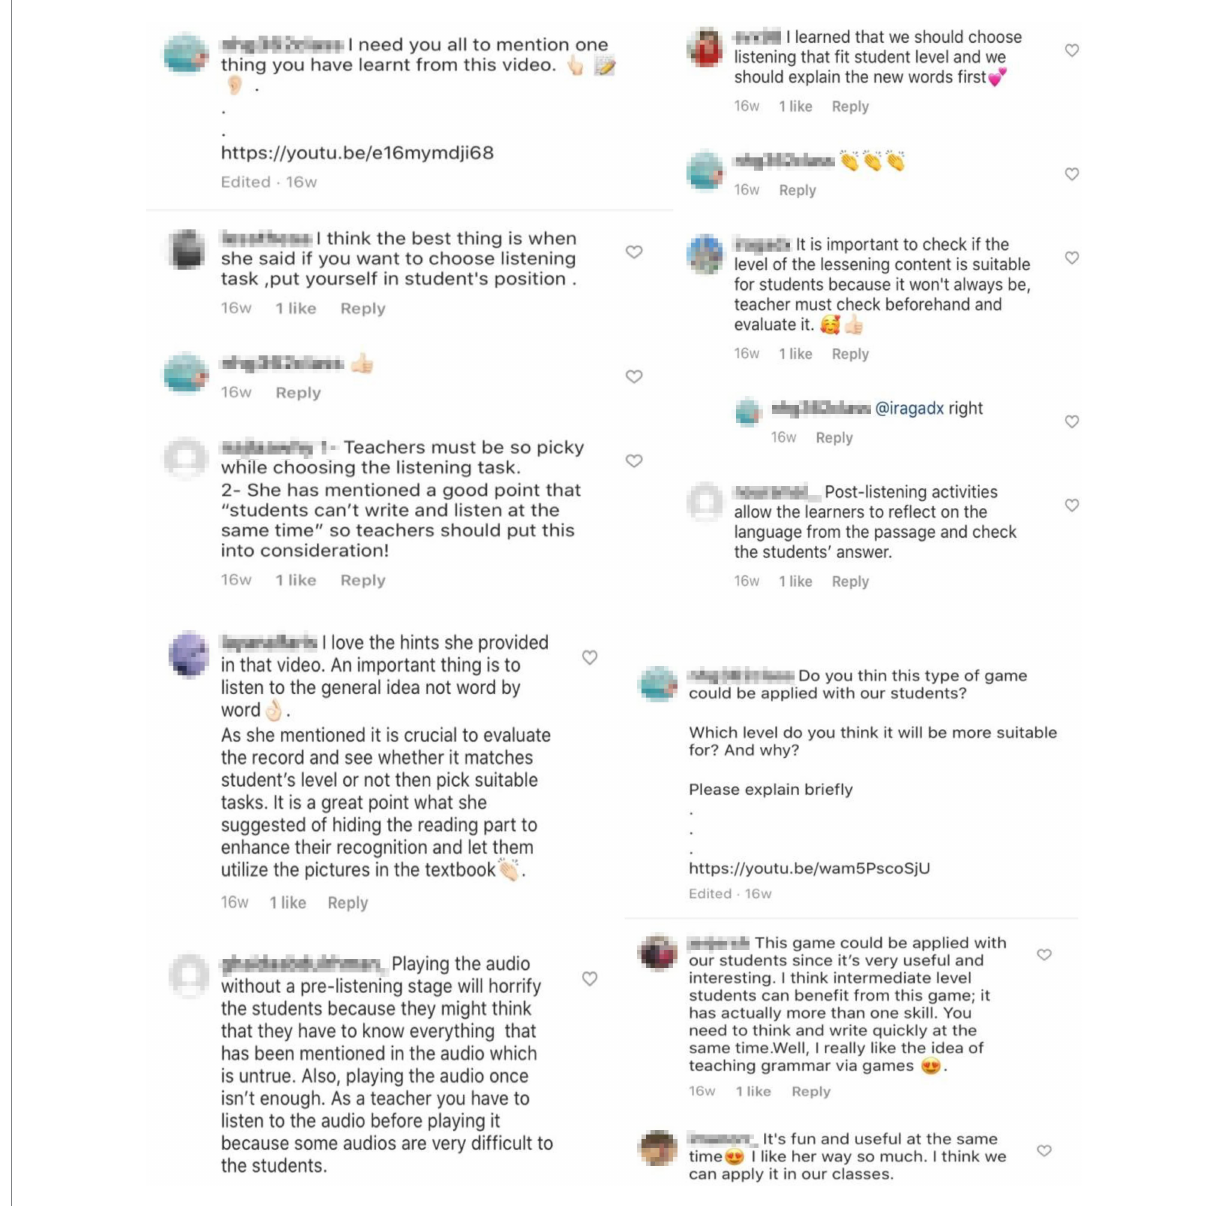
FIGURE 4 Students’ actual responses in class on